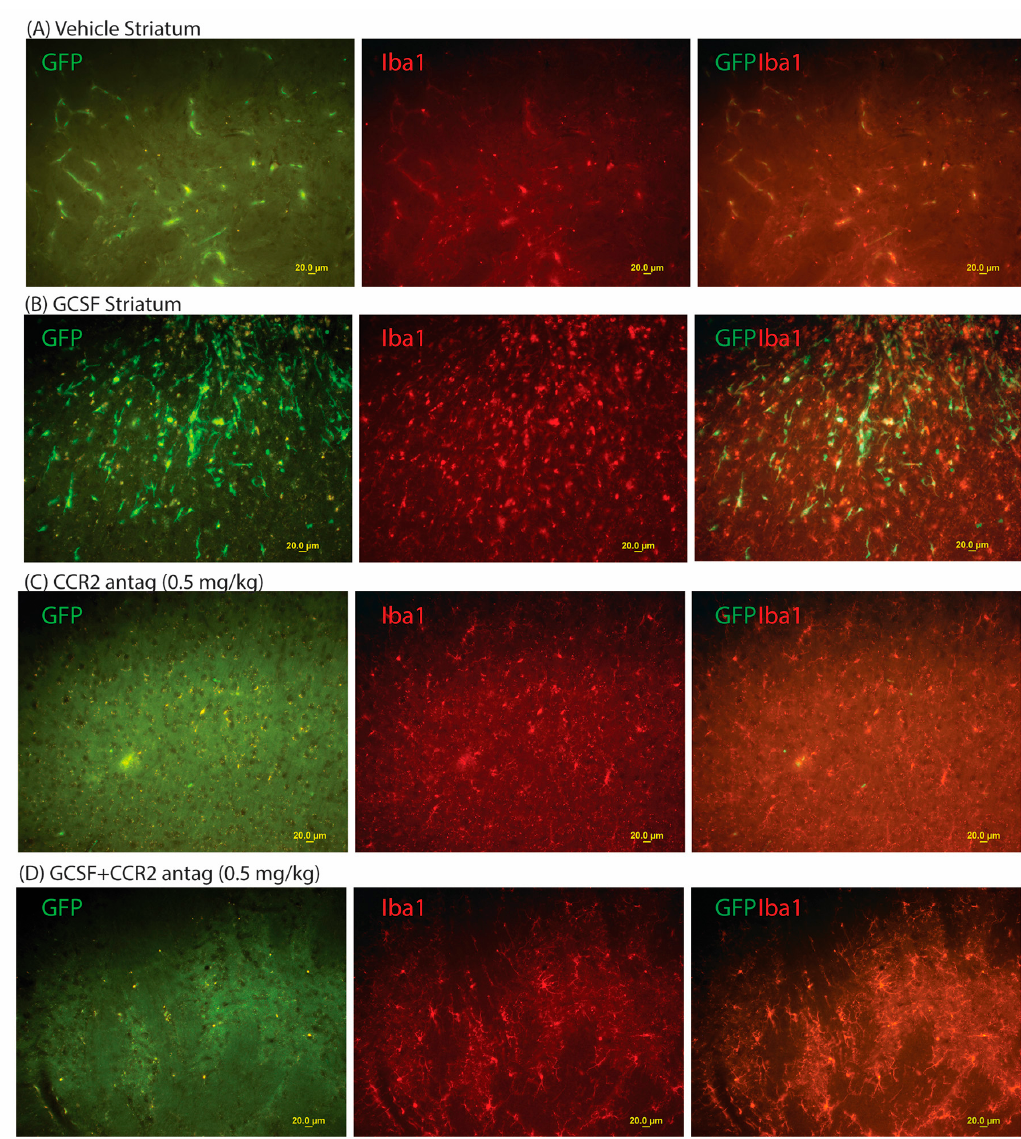
Figure 2. Effects of right-sided CCI on microgliosis (Iba1+ cells) and infiltration of GFP+ cells into the right corpus striatum at two weeks. Left-hand panels show GFP+ cells; middle panels show Iba1+ cells (microglia); right-hand panels show the composite image (GFP/Iba1). ( A ) Effects of vehicle treatment. Most of the GFP+ cells are within capillaries; ( B ) effects of G-CSF (100 µg/kg daily × 3 days) treatment after CCI. G-CSF increased the infiltration of GFP+ cells into the striatal parenchyma. Note that many microglia co-express GFP+, indicating their origin from peripheral monocytes; ( C ) effect of the CCR2 antagonist treatment alone (0.5 mg/kg daily × 3 days). Note that the CCR2 antagonist markedly diminishes the GFP+ signal, even in the capillaries of the striatum; ( D ) effects of G-CSF and CCR2 antagonist treatment (0.5 mg/kg daily × 3 days). Similar to the panels in ( C ), the CCR2 antagonist blocked the recruitment of GFP+ cells. The effects of the combination of G-CSF and 2.0 mg/kg CCR2 antagonist are not shown, but are similar to those produced by G-CSF and 0.5 mg/kg CCR2 antagonist as in Figure 2D (scale bar = 20 µm).